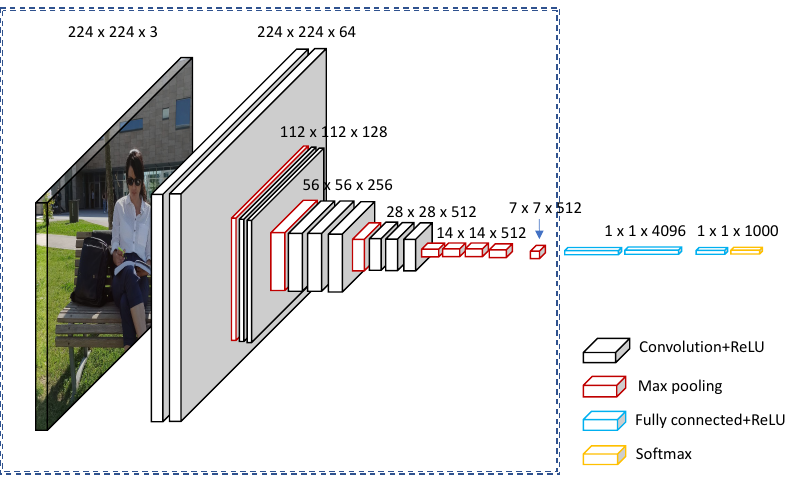
Figure 3. Above a graphical depiction of Convolutional Layer + ReLU and Max Pooling is given (Retrieved from [42]).